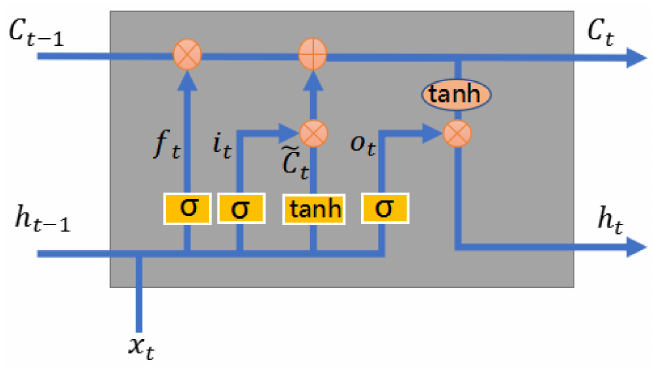
Figure 3. Long short-term memory